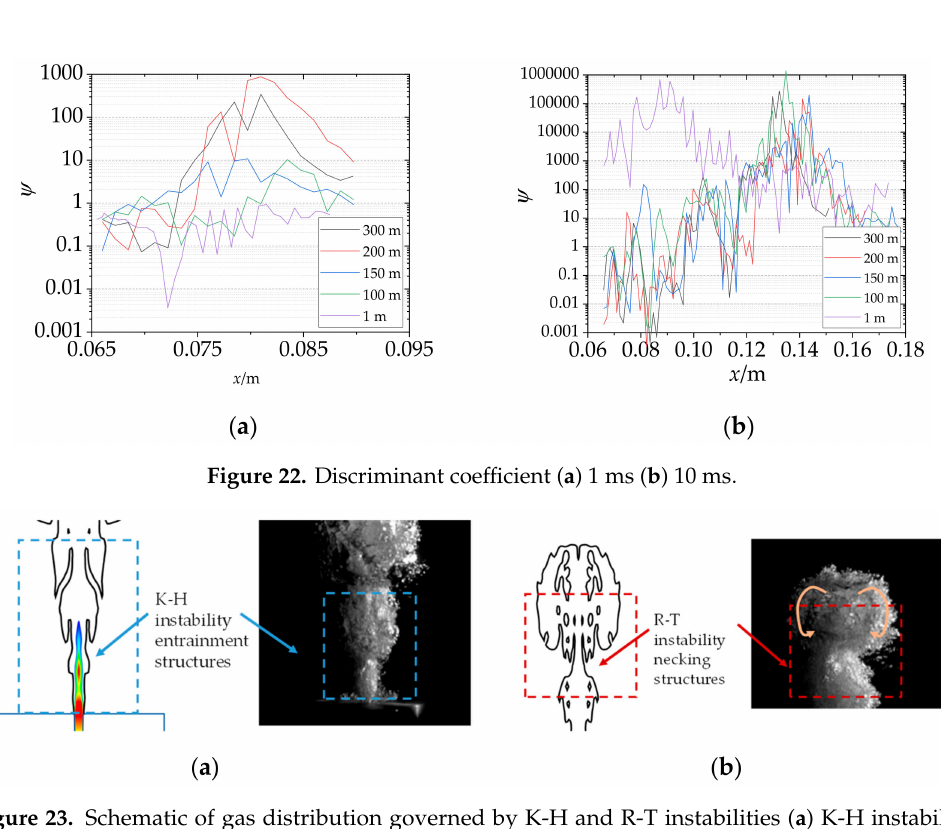
Figure 23. Schematic of gas distribution governed by K-H and R-T instabilities ( a ) K-H instability governed structures ( b ) R-T instability governed